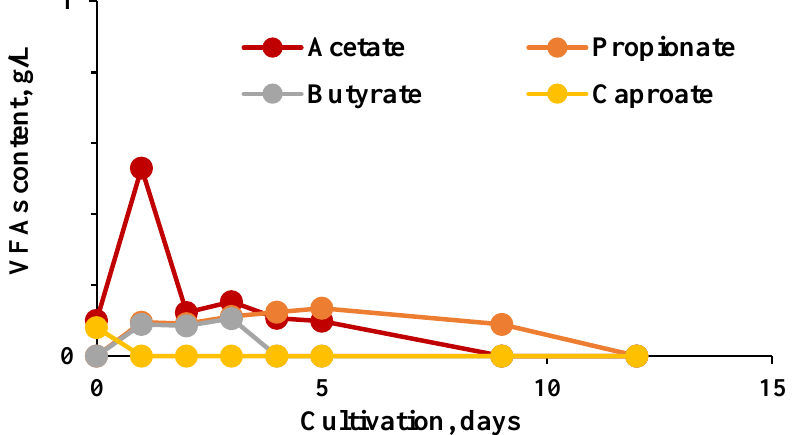
Figure 7. Profile of VFA during a methane-generating process. The values for i-But, i-Val, and Val are zero.